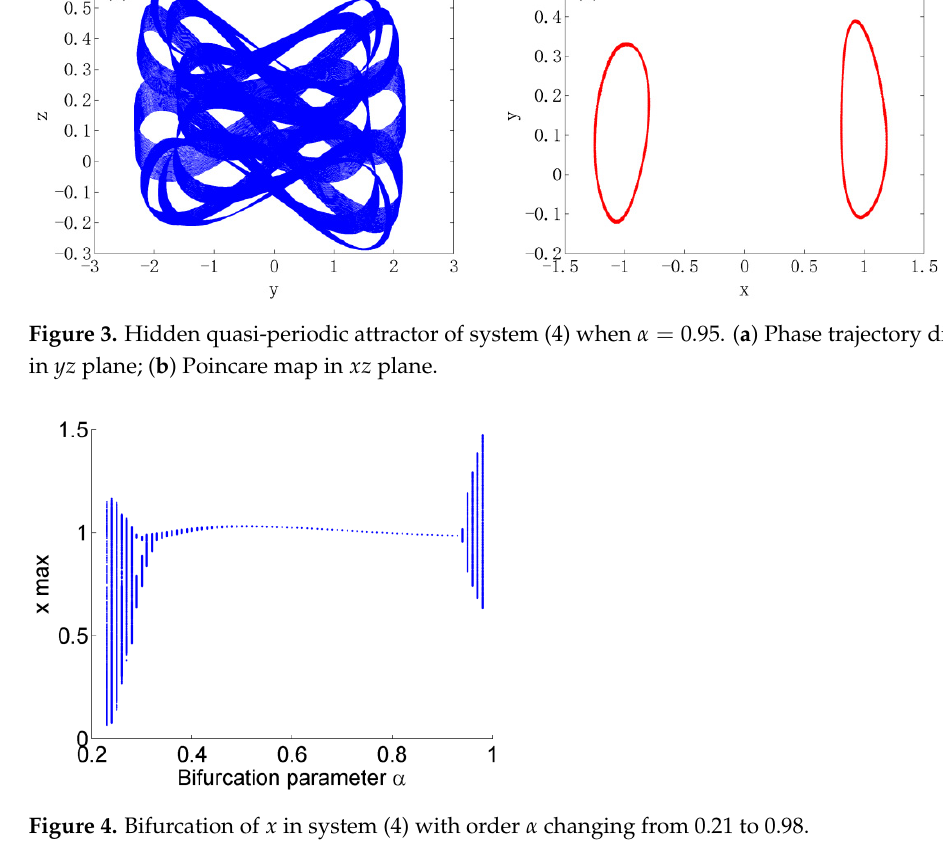
Figure 2. Hidden periodic attractor of system (4) when 0.5 α= . ( a ) Phase trajectory diagram in yz plane; ( b ) Poincare map in xz plane.